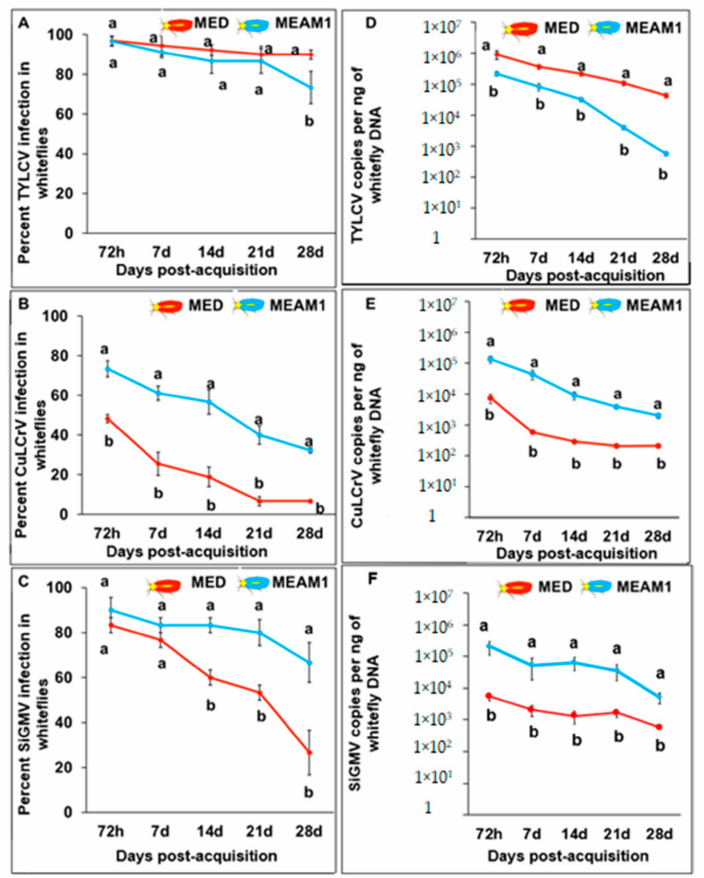
Figure 2. Retention of TYLCV, CuLCrV, or SiGMV by B. tabaci MEAM1 and B. tabaci MED. Values are means ± SE. Means with different letters are significantly different as separated with Tukey’s